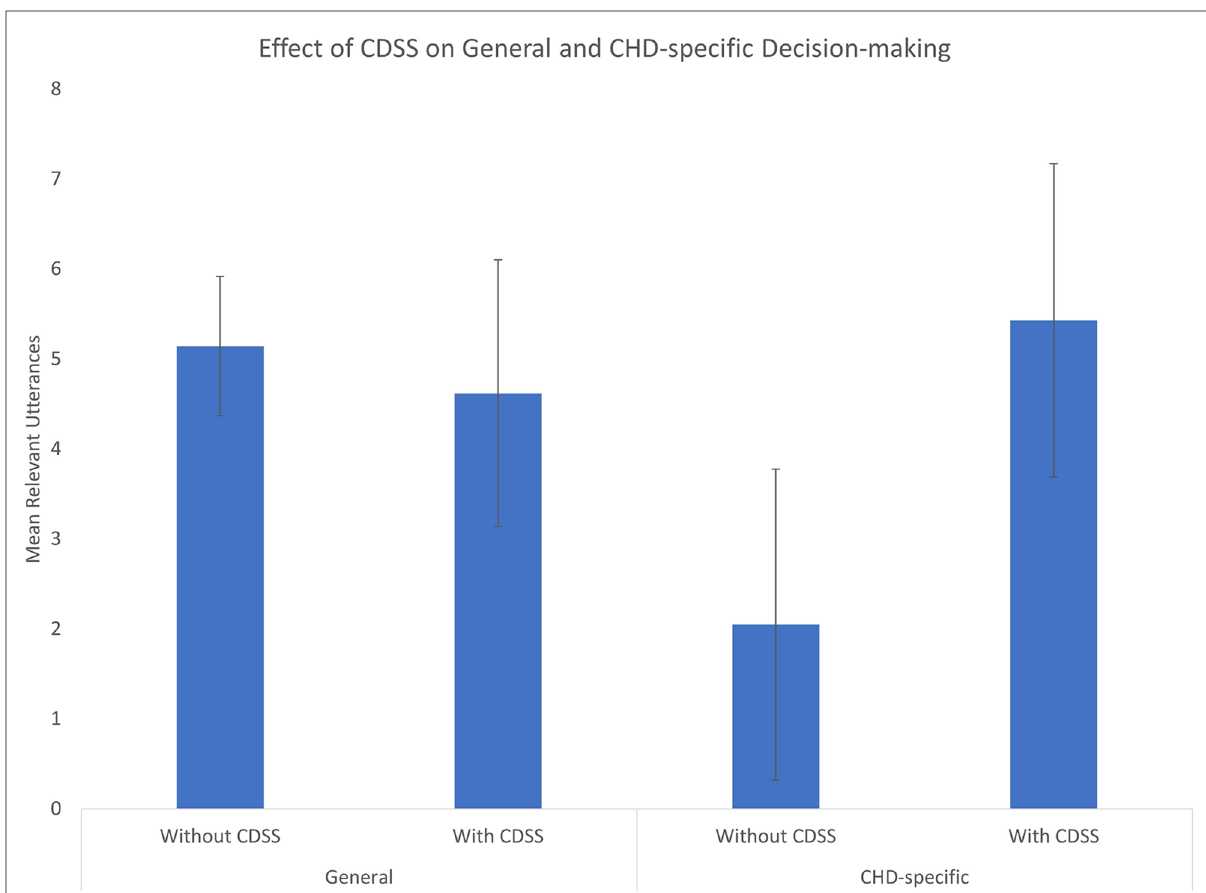
FIGURE 2 Effect of MyHeartPass ™ on ED physicians ’ general and CHD-speci fi c decision-making. The use of MyHeartPass ™ (CDSS) is seen to have increased utterances of CHD-speci fi c decisions without effecting utterances of general decisions. Error bars represent the 95% con fi dence